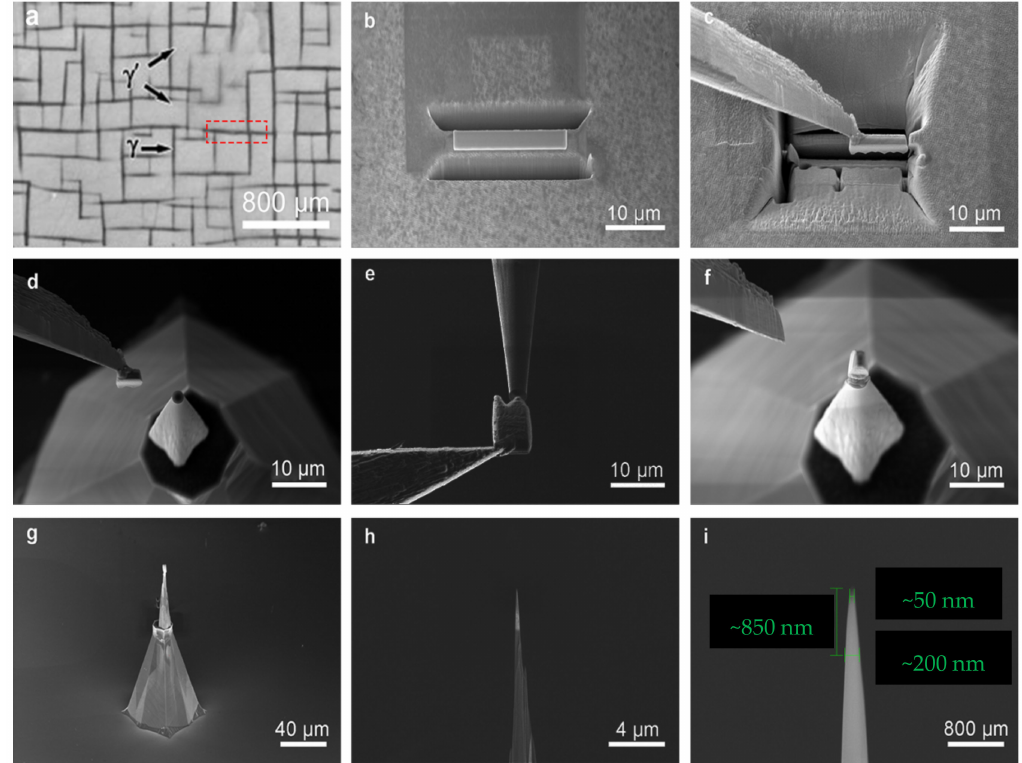
Figure 1. Example of the standard lift-out APT specimen preparation. ( a ) Platinum deposition; ( b ) cutting; ( c ) fine cutting; ( d ) lift-out; ( e ) welding; ( f ) separation; ( g ) annular milling; ( h ) cleaning; ( i )